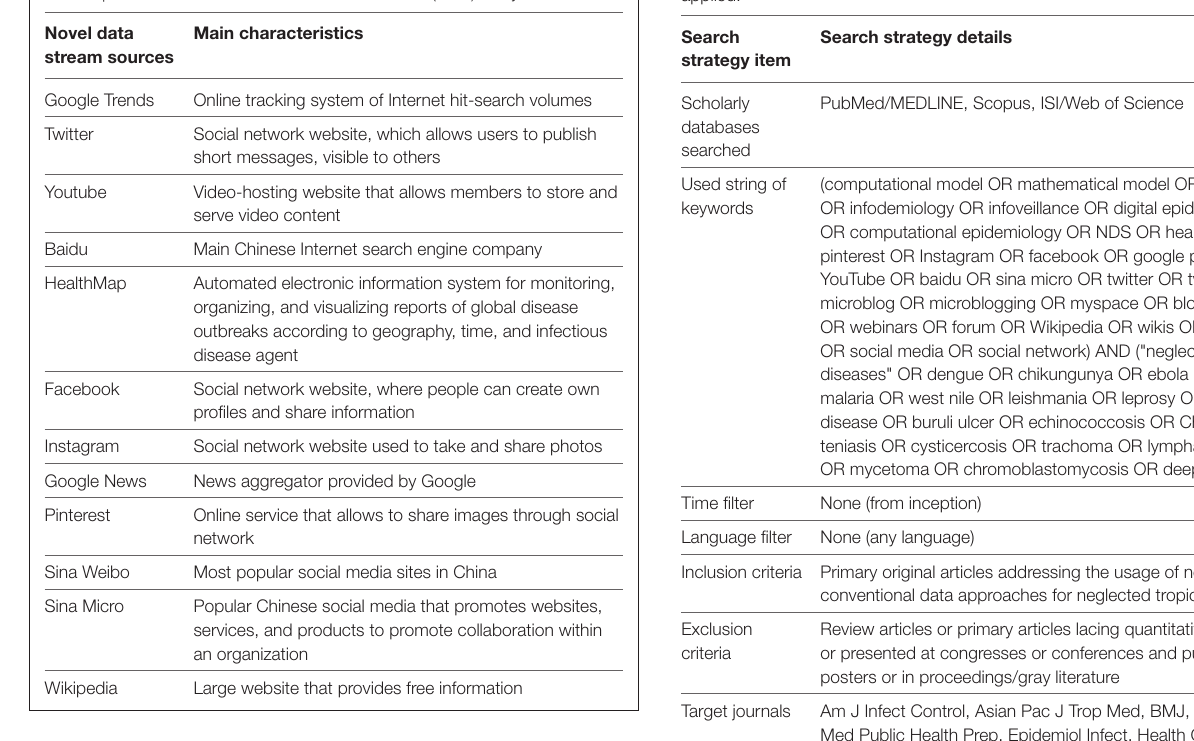
BOx 1 | Main characteristics of novel data streams (NDS)